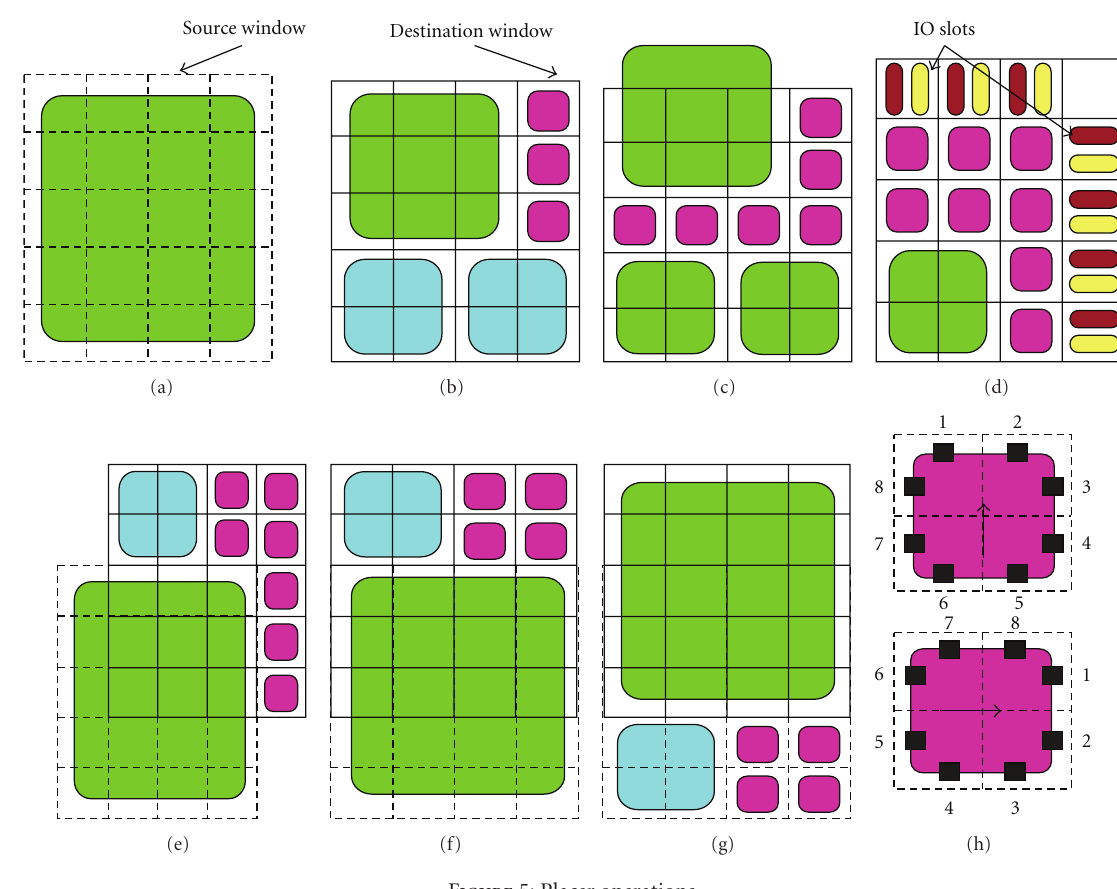
Figure 5: Placer